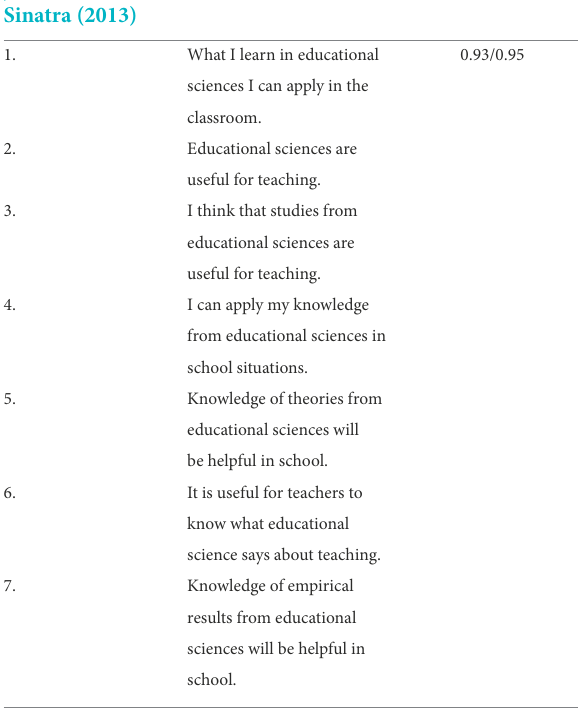
TABLE 2 Scales used for the perceived utility value of educational sciences t 1 and t 2. Johnson and Sinatra